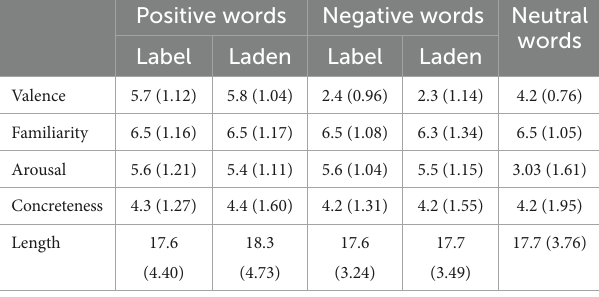
TABLE 1 Means (M) and standard deviation (SD) for Chinese emotion- label, emotion-laden, and neutral words.